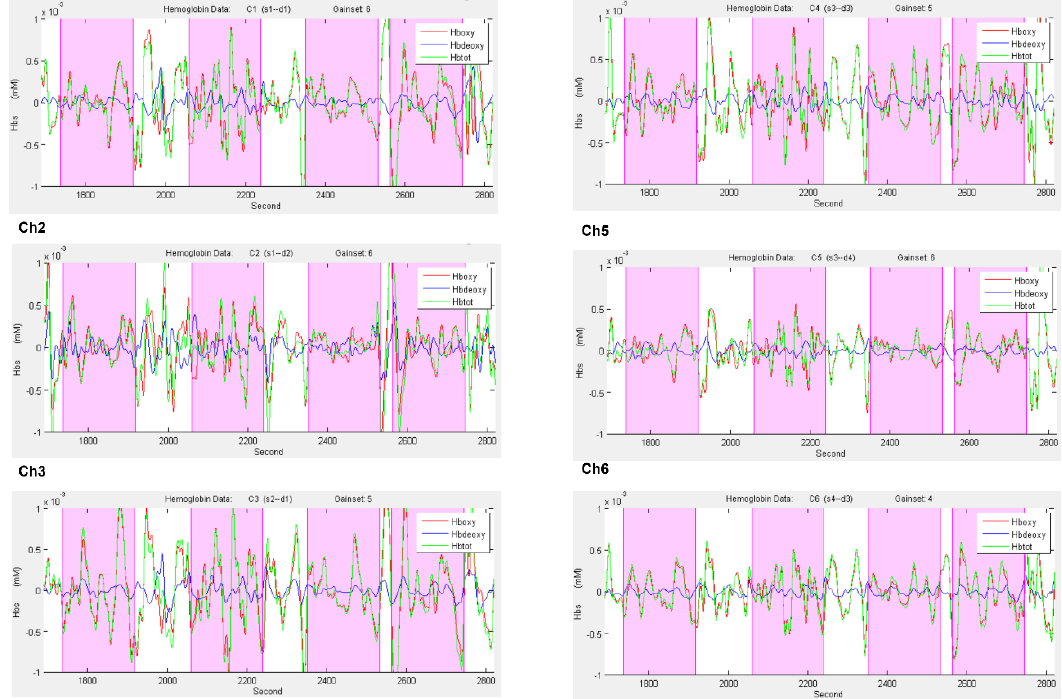
Figure 3. Hemodynamic signal time course for all channels under the four conditions. The figure shows the time course plots of O2Hb (red) and HHb signal (blue) for each channel when performing the following tasks: motor and linguistic tasks during the control condition and motor and linguistic tasks during the explicit IA condition.